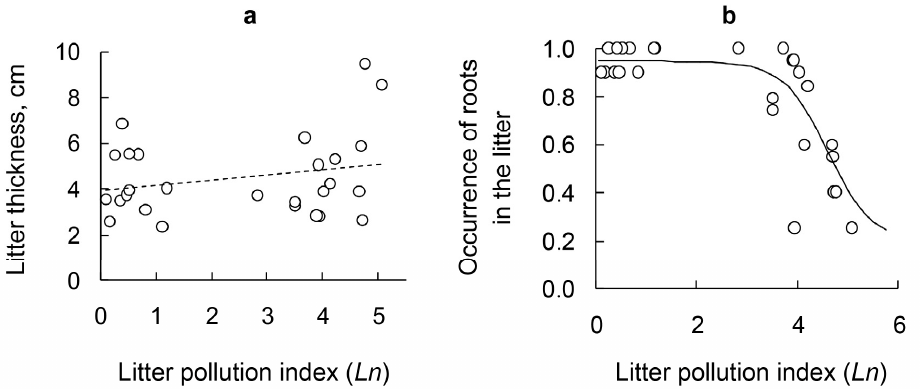
Figure 5. The dependencies of the litter thickness ( a ): linear approximation; statistically insignificant dependency) and the root occurrence in the litter ( b ): logistic approximation; statistically significant dependency) on the index of litter pollution with heavy metals.